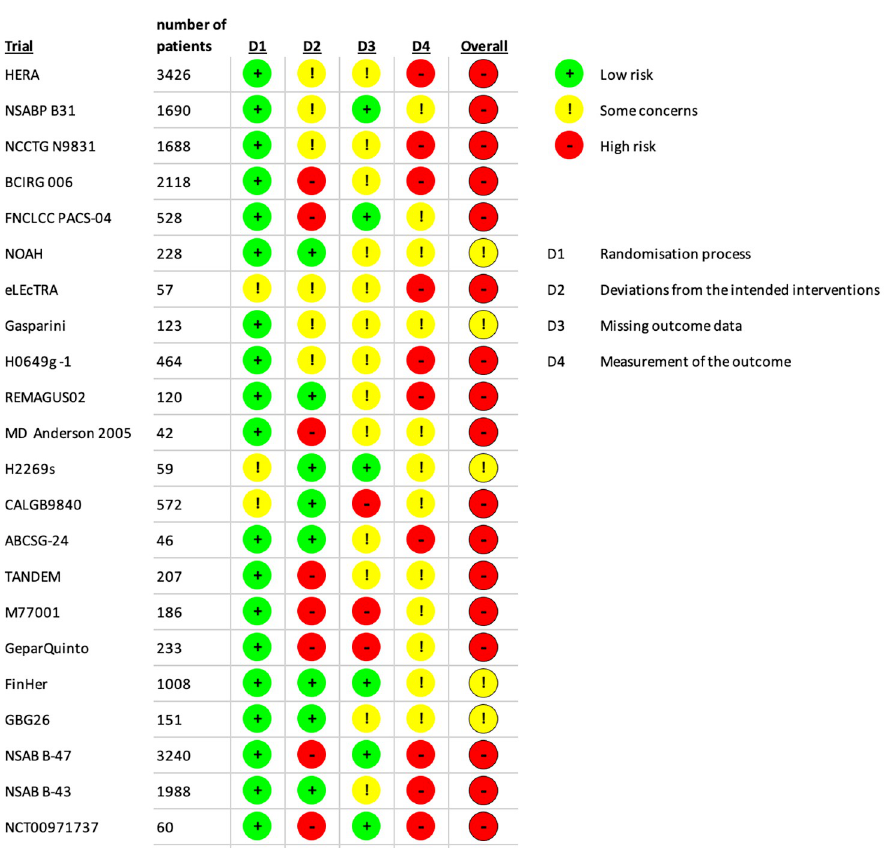
Fig 2. Risk of bias assessment for the 20 trials included in the